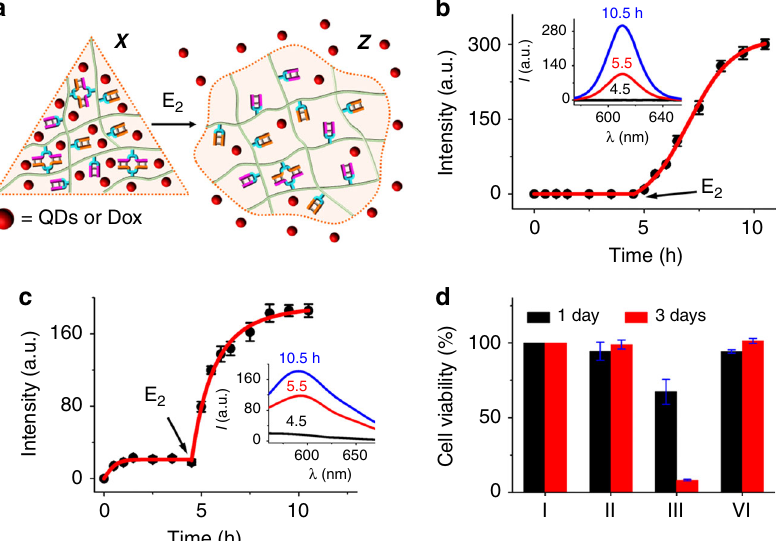
Fig. 5 Triggered release of loads from the CDN hydrogels. a Schematic presentation of the release of CdSe/ZnS semiconductor quantum dots (QDs) or of doxorubicin (Dox) from CDN hydrogel X upon the E 2 -stimulated transition of the medium-stiffness hydrogel X to the low-stiffness CDN hydrogel Z. b Time-dependent release pro fi le of CdSe/ZnS QDs. c Time-dependent release pro fi le of Dox. All data are presented as the mean ( n = 3) and error bars in b and c represent standard deviation. d Cytotoxicity of the released anticancer drug Dox from hydrogel X without or with trigger E 2 toward MDA-MB-231 breast cancer cells. The cell viabilities (% of the control, entry I) are presented in the form of bars: (I) Untreated cells; (II) Cells treated with the released Dox from hydrogel X without E 2 ; (III) Cells treated with the released Dox from hydrogel X in the presence of E 2 ; (IV) Cells treated with the HEPES